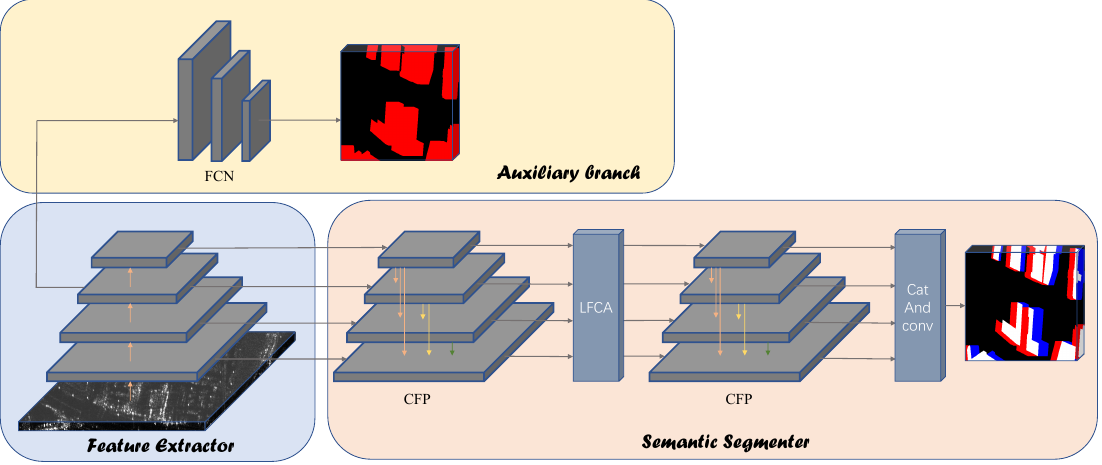
Figure 2. Overall